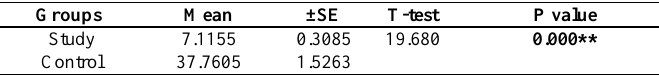
Table 3: Serum vitamin D concentration (ng/mL) (mean ±SE) and statistical difference in the study and control groups Groups